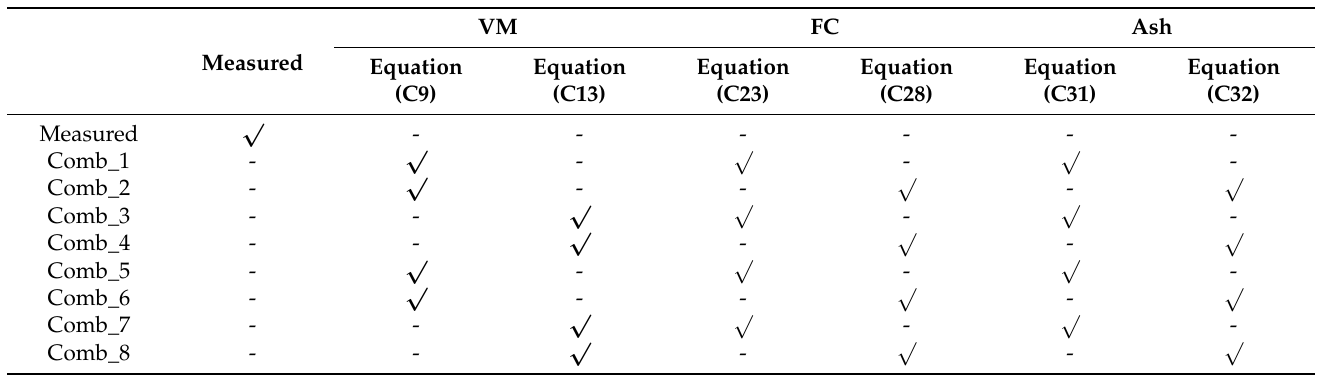
Table 7. Summarization of each combination model for prediction of